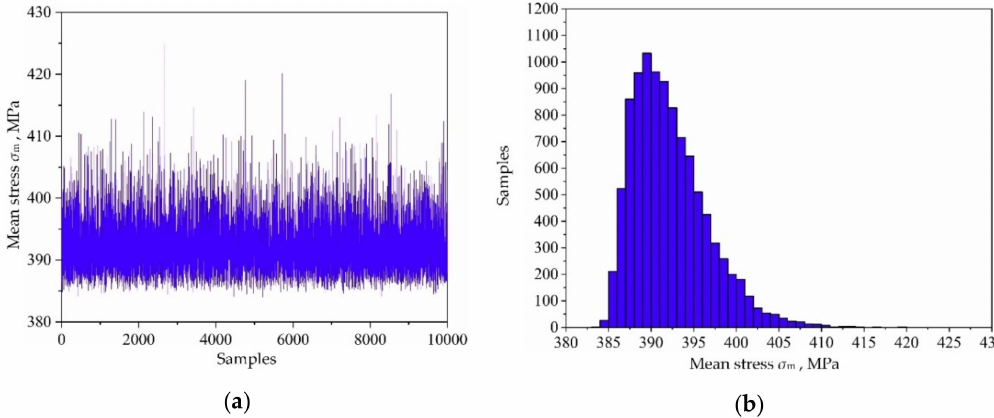
Figure 10. Output responses of decomposed IKM-1: ( a ) simulation history, ( b ) probabilistic distribution.